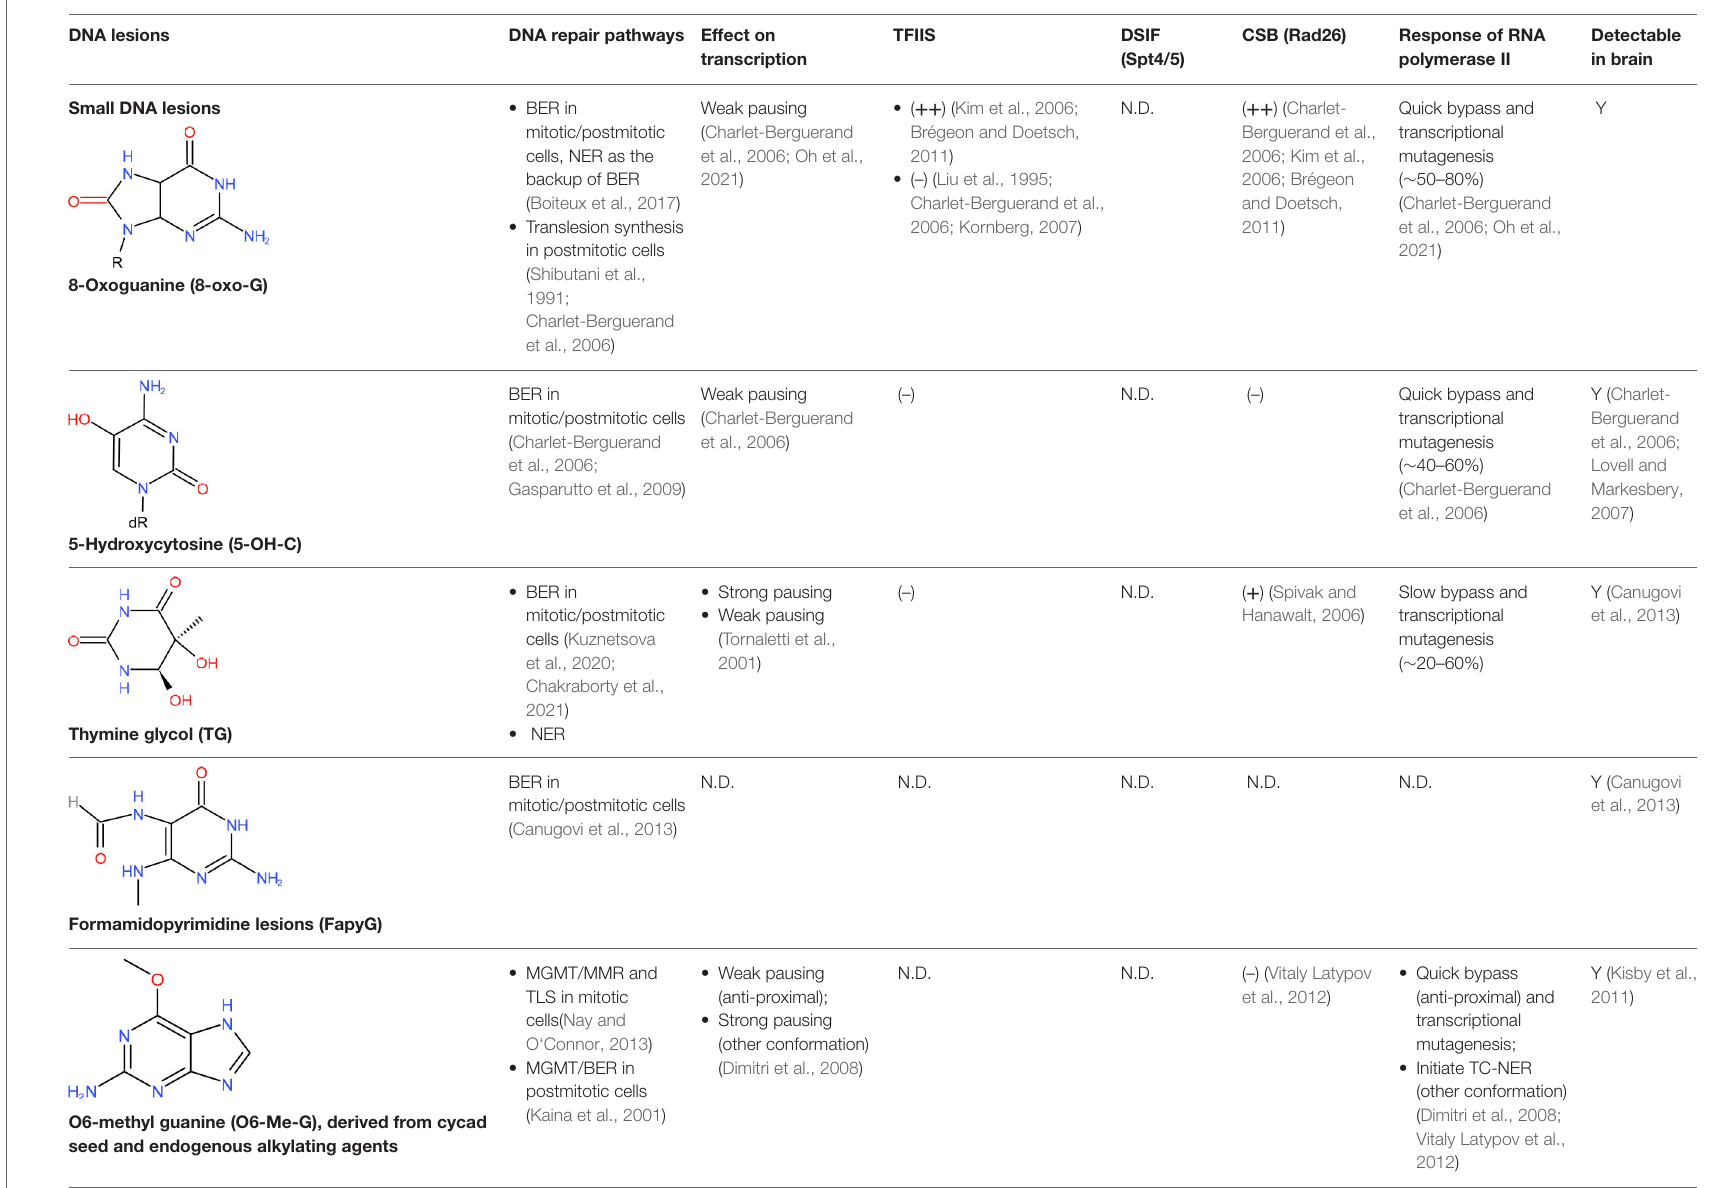
TABLE 1 | Examples of DNA lesions that stalls RNA Pol